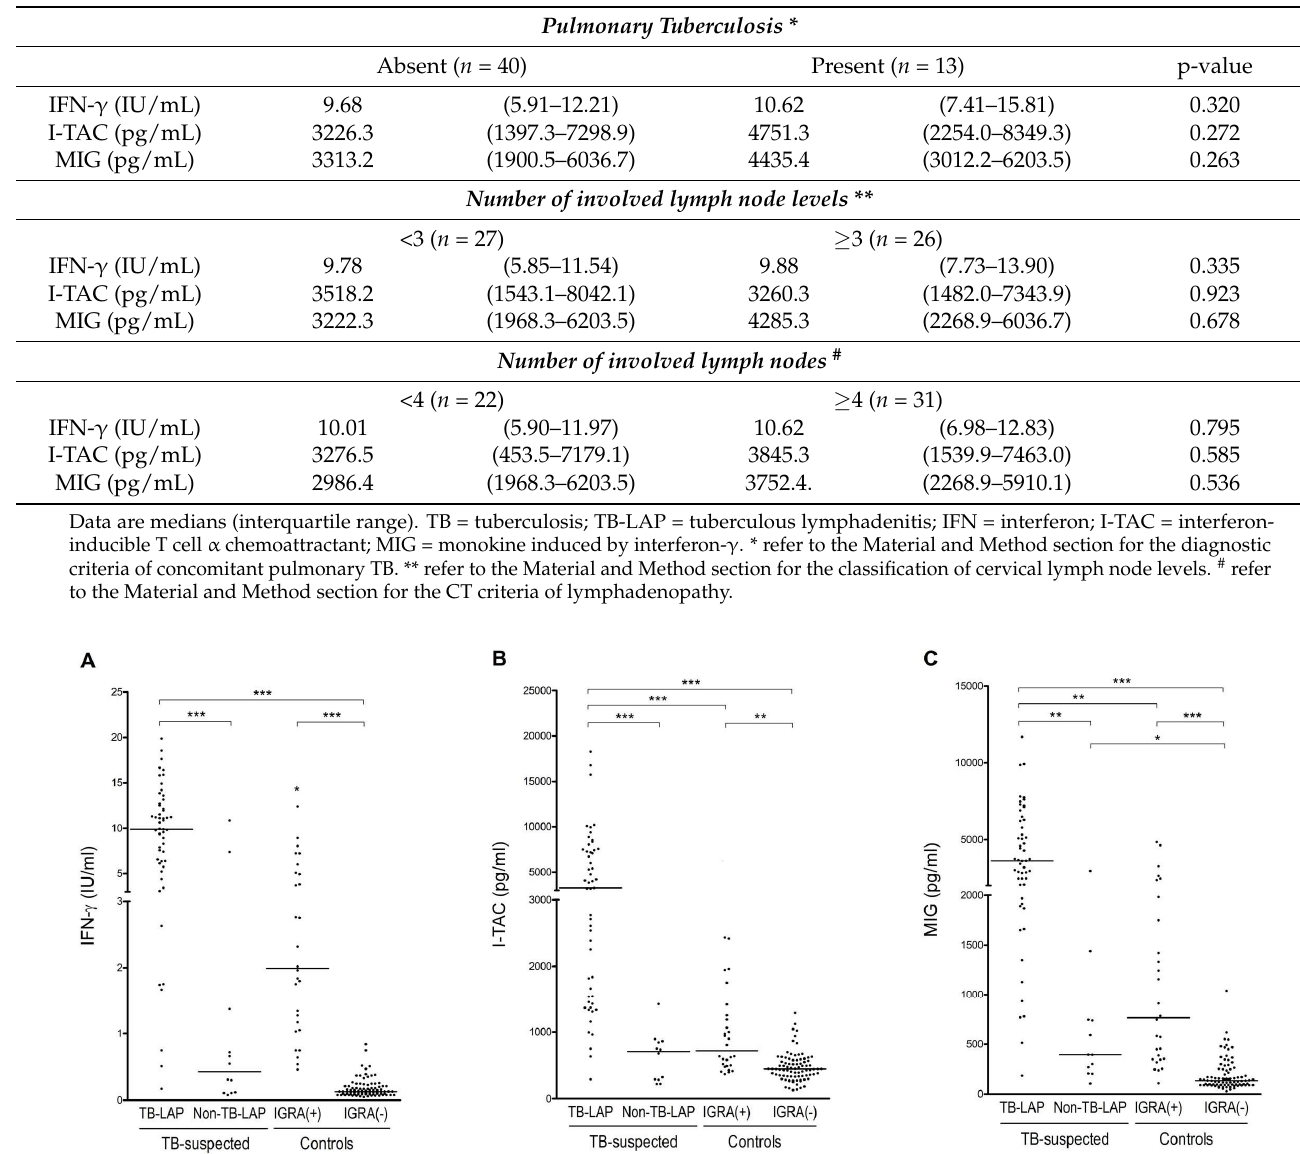
Table 3. TB antigen stimulated marker levels according to clinico-radiological features of TB-LAP patients.